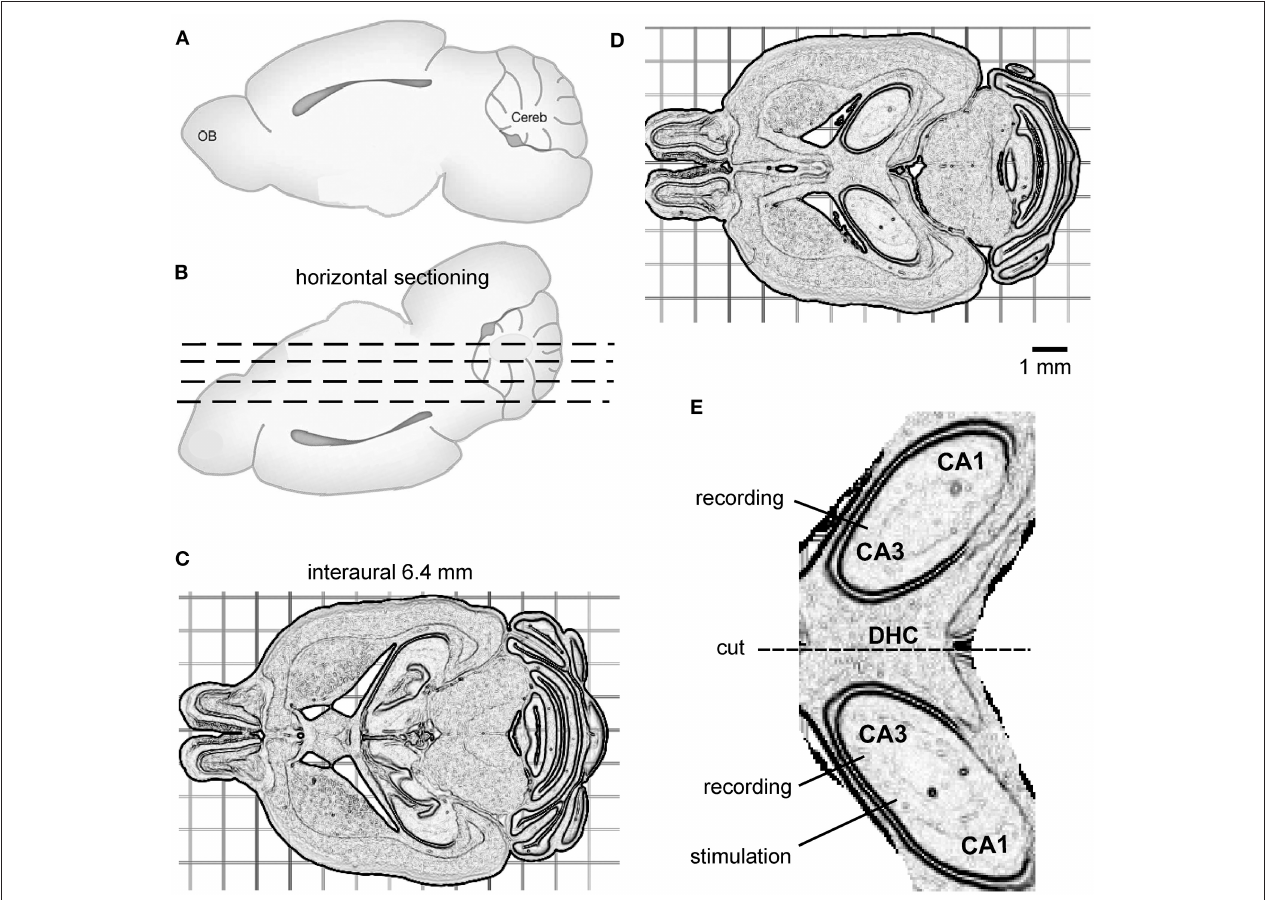
FIGURE 1 | The preparation of bilateral hippocampal slices. (A,B) Cartoons showing a mouse brain with its cerebral cortex or dorsal surface facing down for horizontal vibratome sectioning (dashed lines). (C) Several horizontal sections were cut from the ventral part of the brain to reach the horizontal level corresponding to interaural 6.4mm. (D) A 600- µ m-thick slice was then obtained. The slice encompassed bilateral dorsal hippocampal and connecting DHC tissues. (E) An enlarged drawing showing isolated, bilaterally connected hippocampal tissue. The general positions of a stimulating electrode and two recording electrodes are